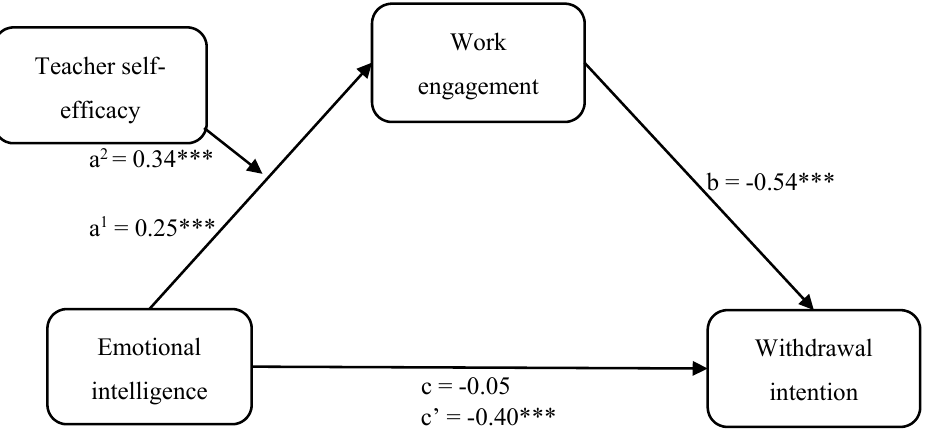
Figure 2. Path analysis of the hypothesized model of teacher self-efficacy as moderator of the relationship among emotional intelligence, work engagement and withdrawal intention. *** p < 0.001.